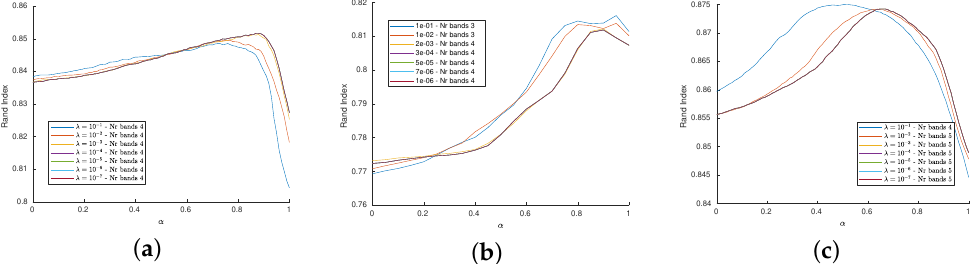
Figure 5. ( a – c ): Dependence of the RI wrt α for several values of λ , from 1 to 10 − 6 for Indian Pines , Pavia University and Salinas HSI datasets, respectively. The RI remains high, there is a peak around α = 0.85 in the former cases, while the Salinas HSI datasets achieve its best performance for α = 0.65 when λ is lower than 1. The number of bands obtained by the dimensionality reduction is stable wrt λ